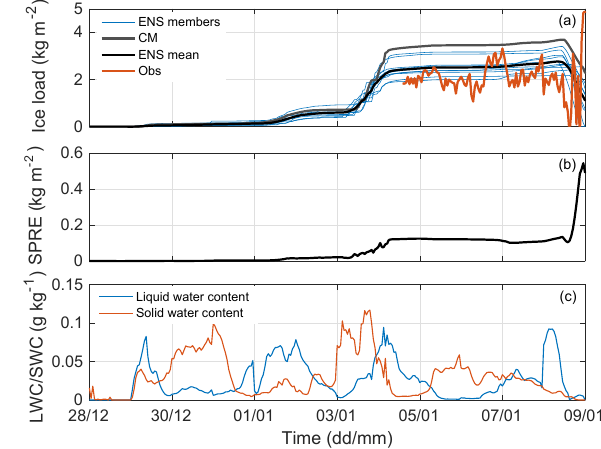
Figure 9. Same as Fig. 6, but for Site B.